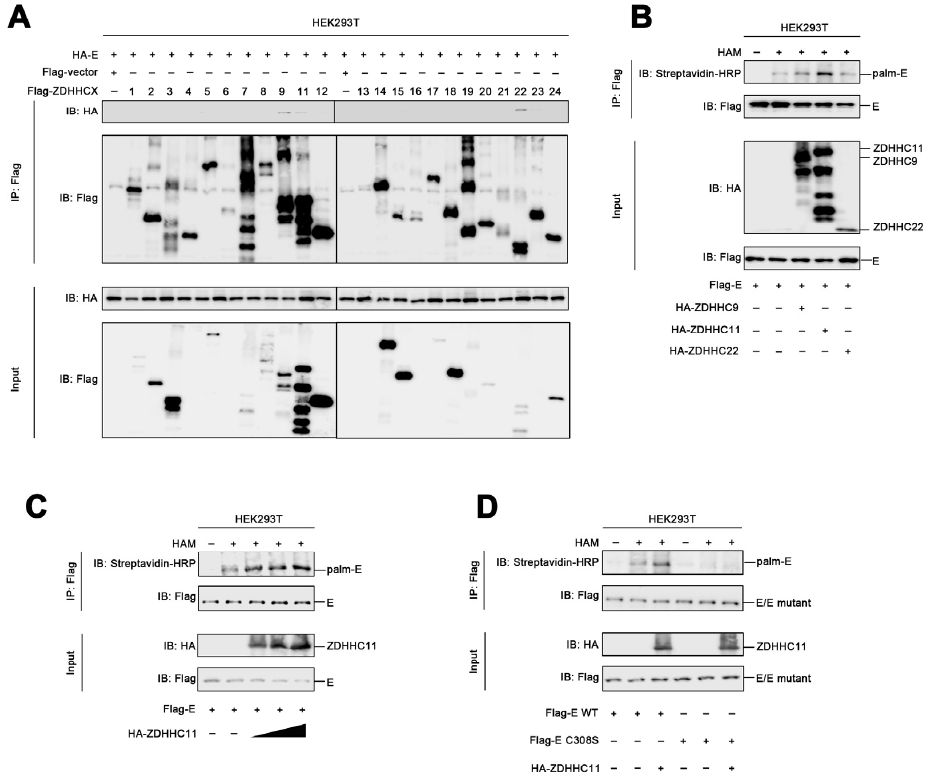
Figure 3. ZDHHC11 mediates the palmitoylation of the ZIKV envelope protein. ( A ) HEK293T cells were transfected with plasmids encoding the envelope protein and ZDHHCXs for 24 h, lysed for co-immunoprecipitation assays using the Flag antibody, and detected using immunoblotting studies with the indicated antibodies. ( B ) HEK293T cells were transfected with plasmids encoding the envelope protein, ZDHHC9, ZDHHC11, and ZDHHC22 for 24 h, lysed for ABE assays, and detected using immunoblotting with the indicated antibodies. ( C ) HEK293T cells were transfected with plasmids encoding the envelope protein and ZDHHC11 for 24 h, lysed for ABE assays, and detected using immunoblotting with the indicated antibodies. ( D ) HEK293T cells were transfected with plasmids encoding the WT or mutant envelope proteins and ZDHHC11 for 24 h, lysed for ABE assays, and detected using immunoblotting with the indicated